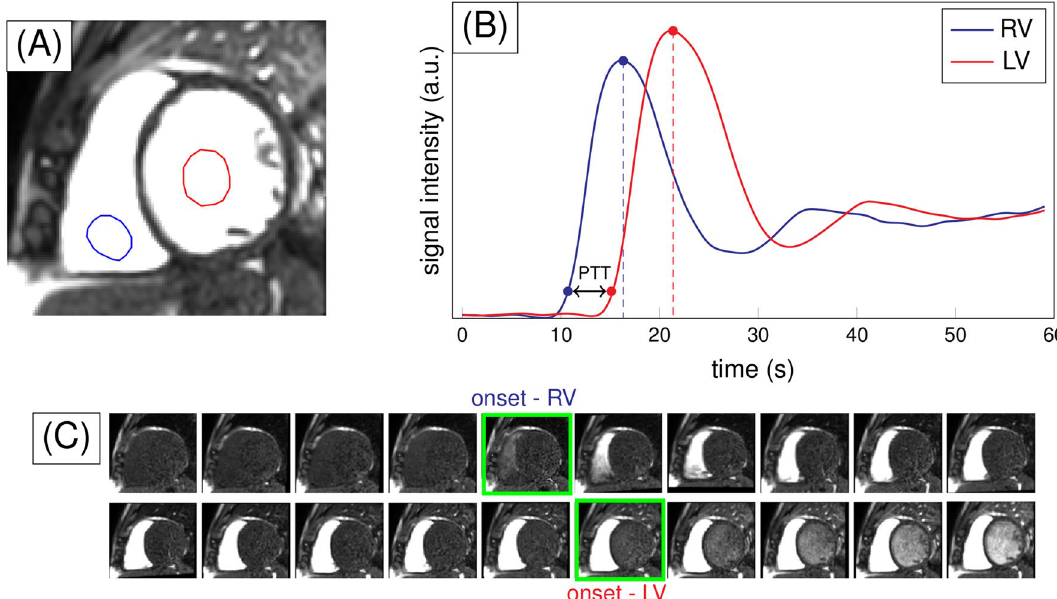
Figure 1. Schematics of the calculation of pulmonary transit time (PTT). ( A ) Region of interests manually traced in the right ventricle (RV, blue) and the left ventricle (LV, red). ( B ) Simulated data of the signal intensity (SI) vs time for the RV and LV. The maxima of the SI are marked. The PTT is the difference between the onsets, determined as the signal at 10% of the maximum values. ( C ) Example of the detection of the onset points in the corrected images. Only a fraction of the images is